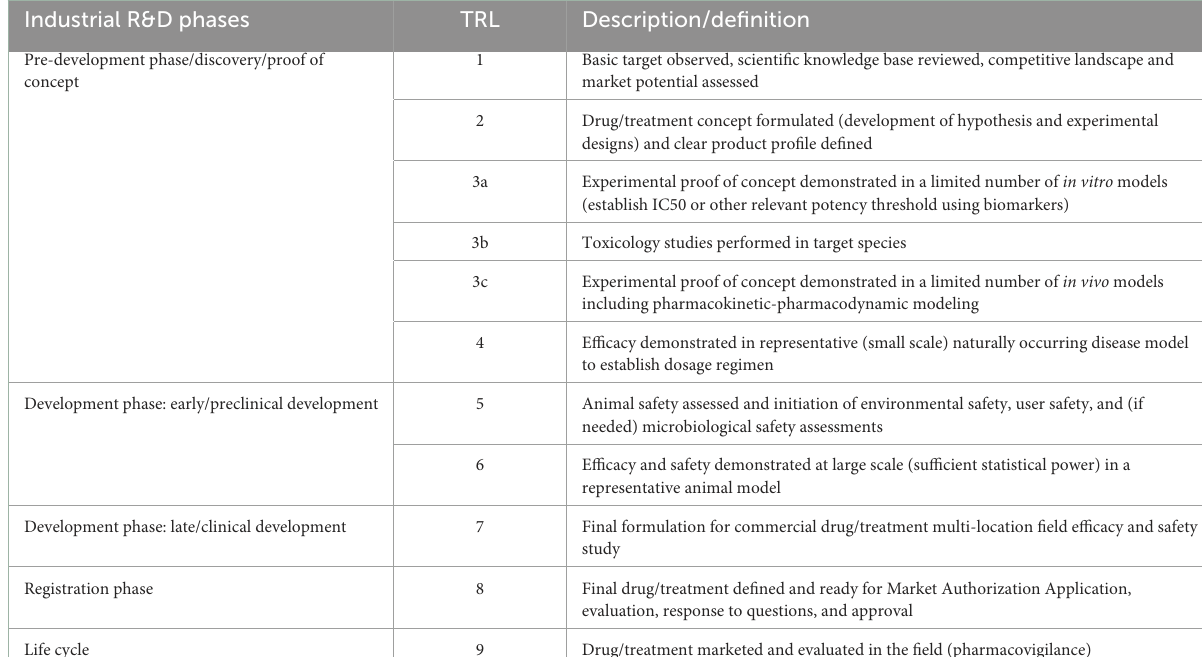
TABLE 3 Technology Readiness Levels for development of drugs for companion animals. Industrial R&D phases